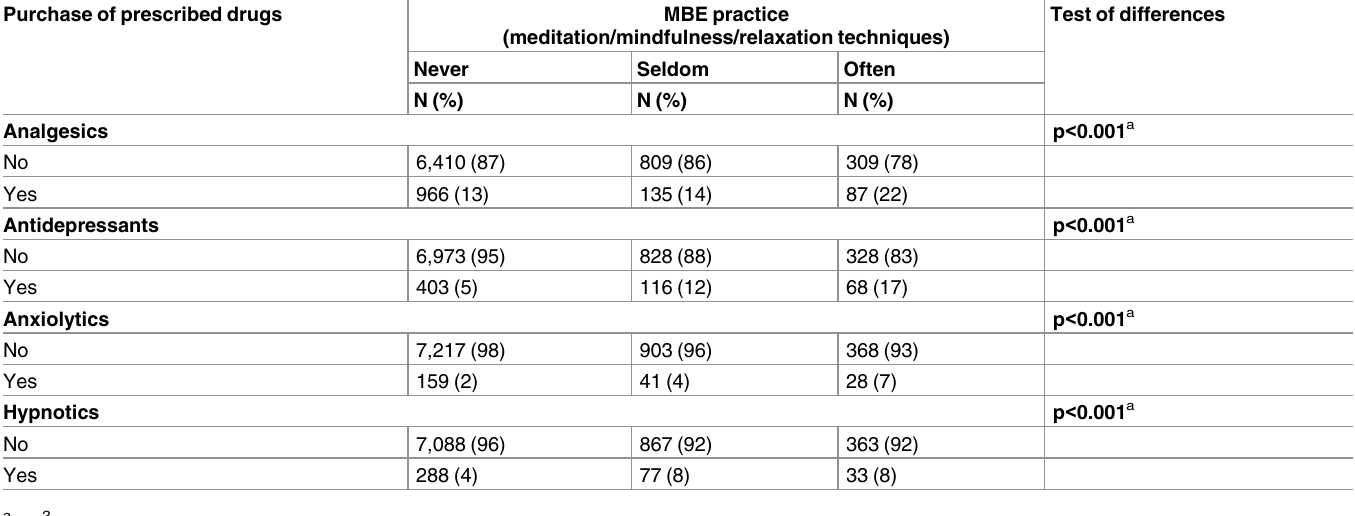
MBE practice (meditation/mindfulness/relaxation techniques)